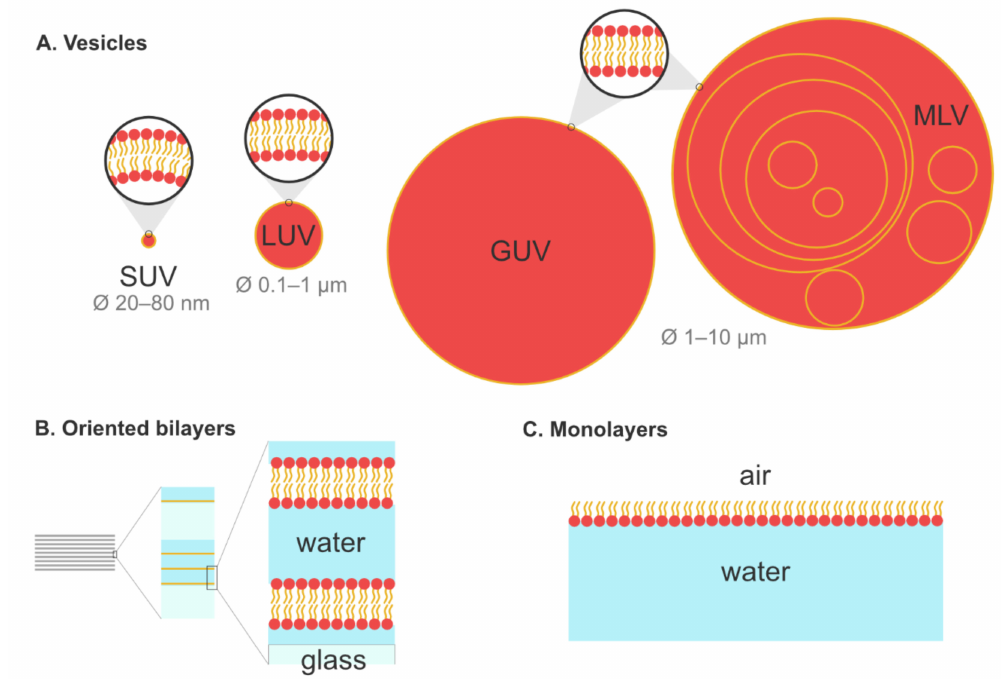
Figure 1. Graphical depiction of lipid self-assemblies classically used as membrane models in biophysical studies. (Panel A ) shows the major types of liposomes and their typical diameter (ø) range: small unilamellar vesicle (SUV), large unilamellar vesicle (LUV), giant unilamellar vesicle (GUV), and multilamellar vesicle (MLV). Vesicular models are drawn to scale to illustrate their discrepancies in size and in terms of membrane curvature. (Panel B ) shows oriented bilayers, where lipid bilayers are deposed on top of glass sheets separated by thin layers of water. (Panel C ) shows how lipids can orient themselves at the air–water interface to form